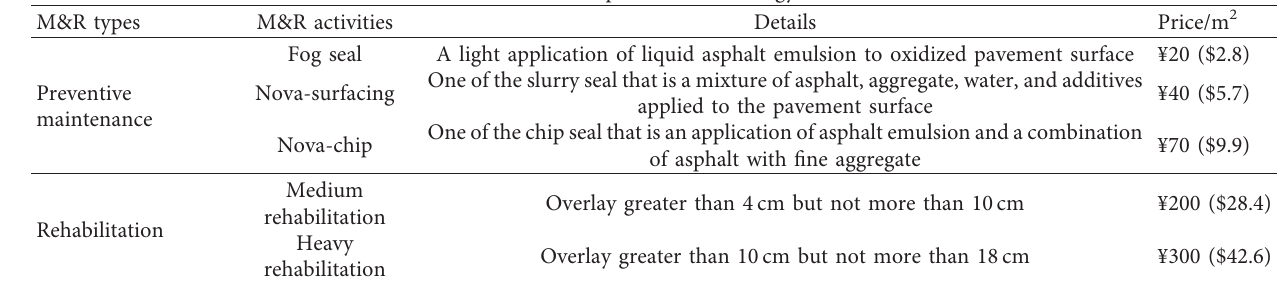
Figure 4: Decision tree. Table 2: Pavement preservation strategy and cost.